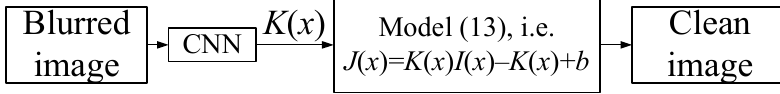
Figure 5. Dehazing of underwater images using all-in-one model.